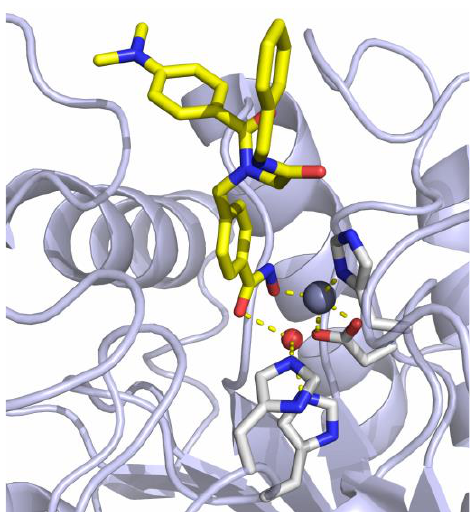
Figure 2. Crystal structure of I in complex with HDAC6 (PDB ID: 6DVN). The catalytic Zn 2+ -ion appears as a gray, the water molecule as a red sphere. Metal coordination and hydrogen bond interactions are shown as dashed yellow lines